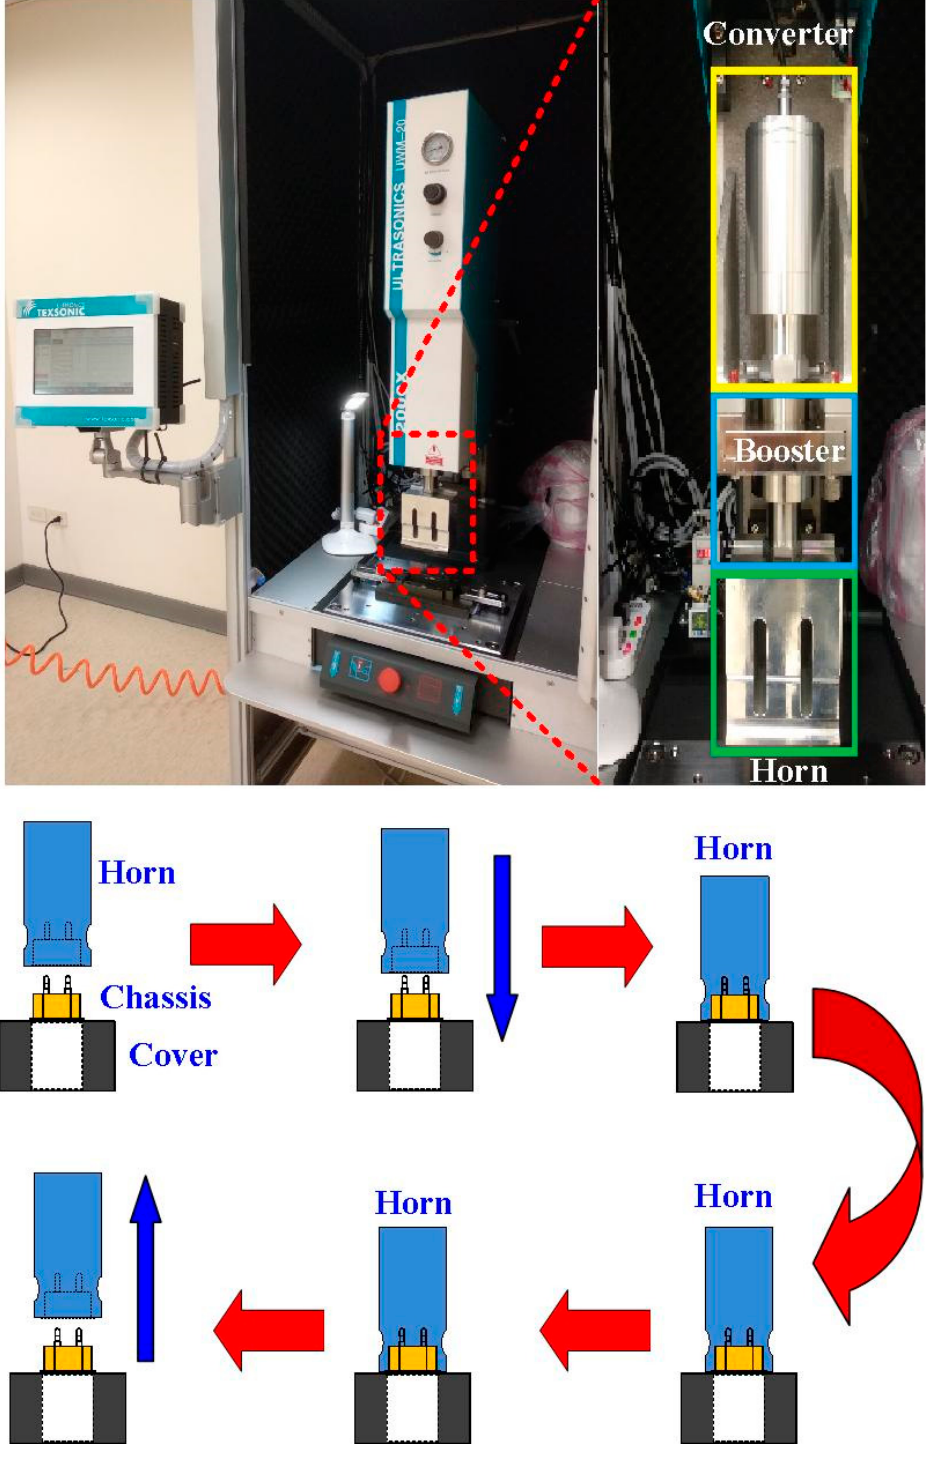
Figure 3. Photo of an ultrasonic plastic welding machine used in this study and schematic illustration of UW processes.